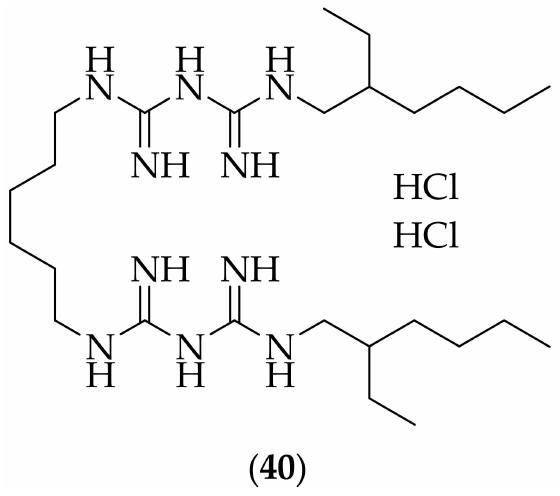
Figure 25. Structure of alexidine dihydrochloride ( 40